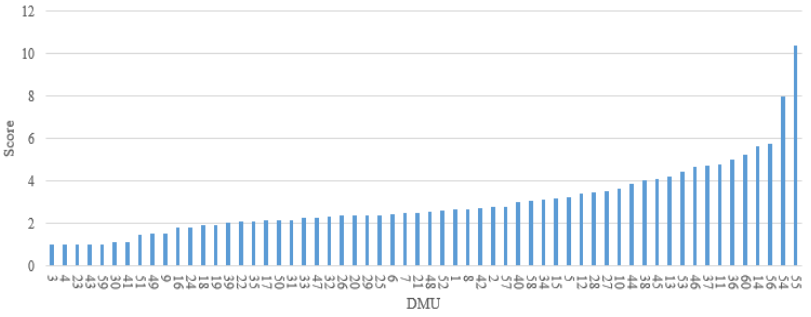
Figure 2. Overall risk scores and corresponding ranking of 60 DMUs.